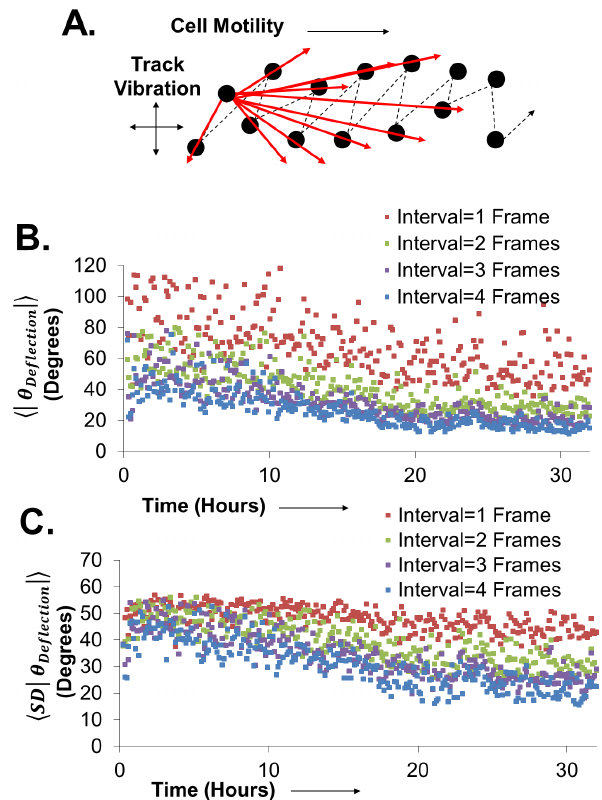
Figure 4. Overlapping Intervals Suppress Angular Noise in Cellular Migration. A ) A schematic representation of a cellular track illustrates how increasing interval size results in the calculation of a cellular migration direction that is resistant to track vibration noise. B ) The average absolute angle of deflection as a function of time for TGF b treated HaCaT H2B mCherry cells for an interval size of one frame shows strong scattering of measurements. Upon increasing interval size, such scattering is suppressed. C ) Such scattering can be also measured by measuring the standard deviation in the absolute angle of deflection, which can be suppressed in a similar manner by increasing interval size. Data represents greater than 1000 cells for each plot.